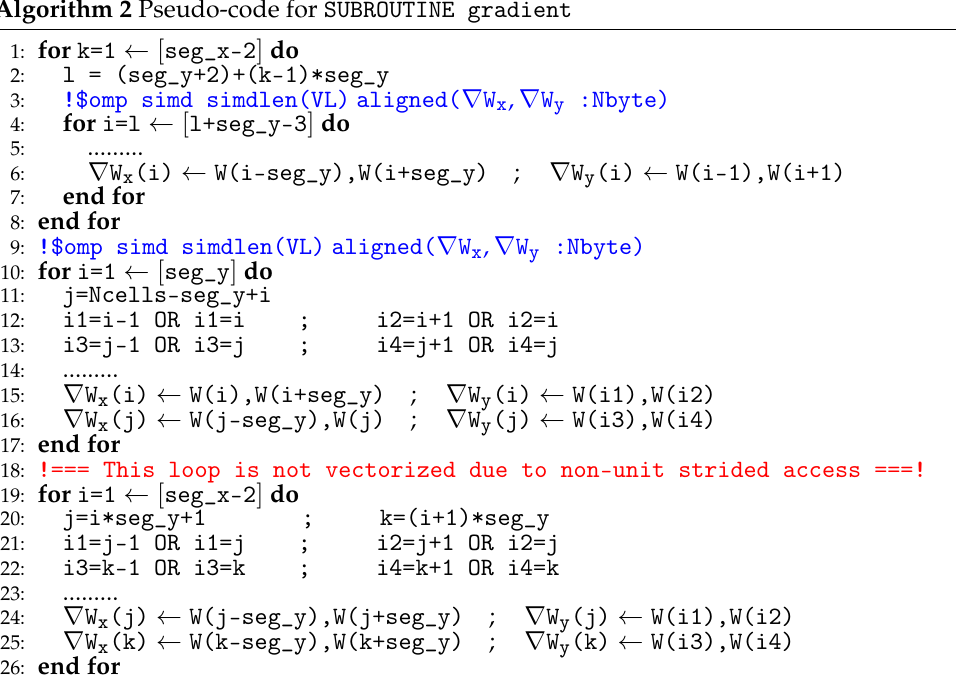
Algorithm 2 Pseudo-code for SUBROUTINE